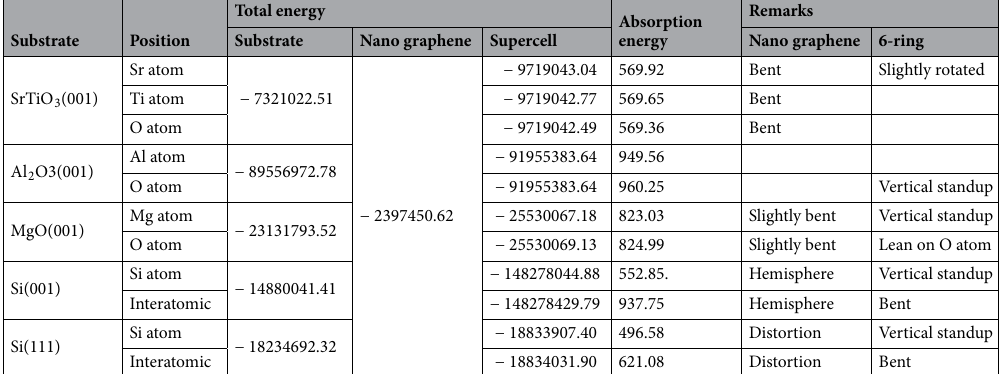
Table 2. Absorption energy estimated on various substrates. Total energy was calculated on individual substrate (E sub ) and 7 six membered ring (E graphene ), one six membered ring (E ring ), and combined system consisting of substrate and graphene, 7 six membered ring and six membered ring and one carbon atom. Absorption energy was estimated by subtracting of all individual materials and combined system.